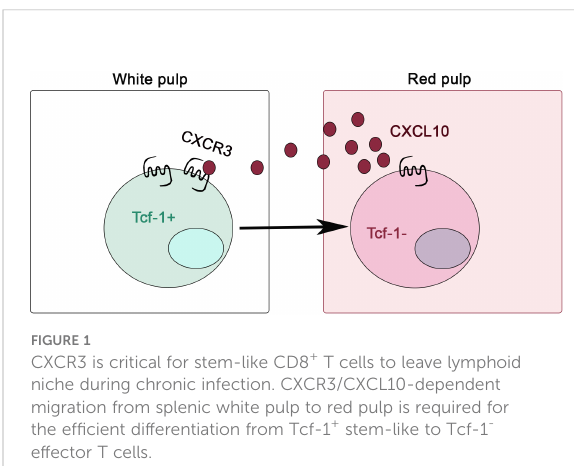
FIGURE 1 CXCR3 is critical for stem-like CD8 + T cells to leave lymphoid niche during chronic infection. CXCR3/CXCL10-dependent migration from splenic white pulp to red pulp is required for the ef fi cient differentiation from Tcf-1 + stem-like to Tcf-1 - effector T cells.